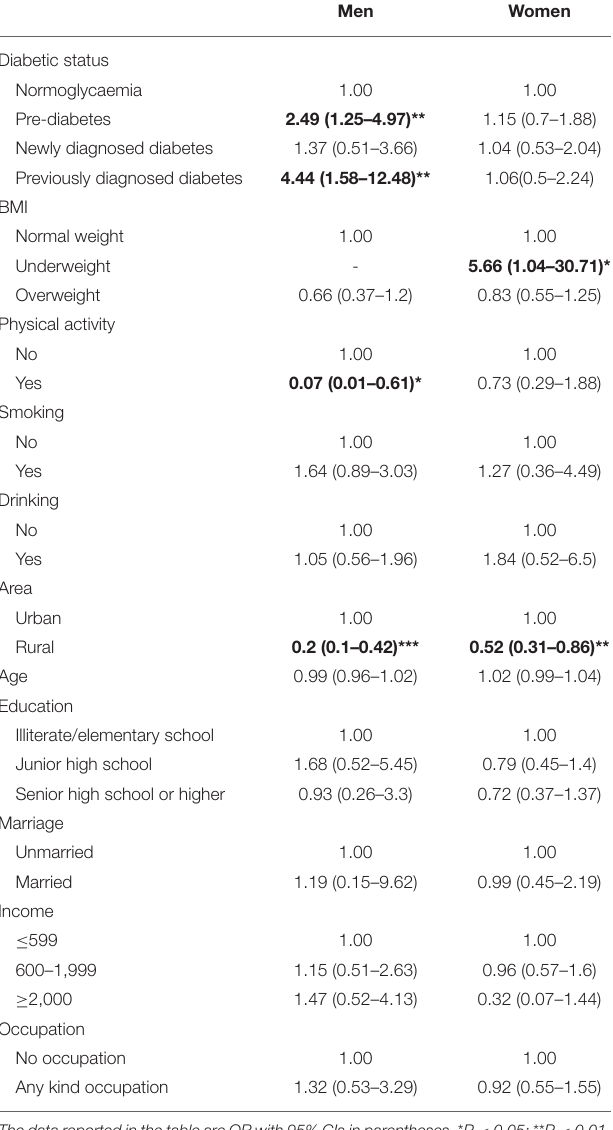
TABLE 5 | Odds ratio (OR) and 95% CI of health conditions, lifestyle factors for depression in men and women in logistic regression models.